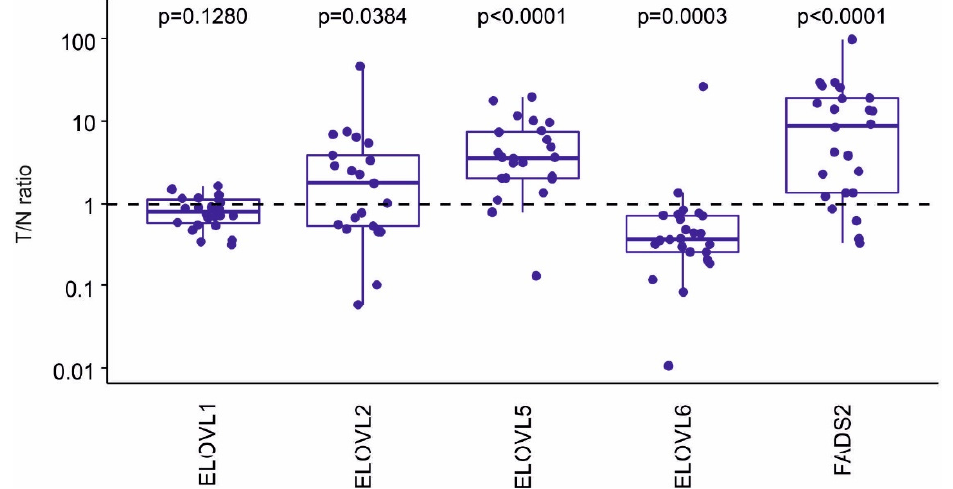
Figure 4. Gene expression (tumor/non-tumor cell ratio, T/N) of significantly altered mRNA levels encoded by the genes involved in fatty acid (FA) elongation/desaturation, as determined in whole tumor and respective non-tumor tissue samples. IPO8 was used as a reference gene. Box plots represent means of 22 colon cancer patients. Statistical significance is indicated above each individual box plot.